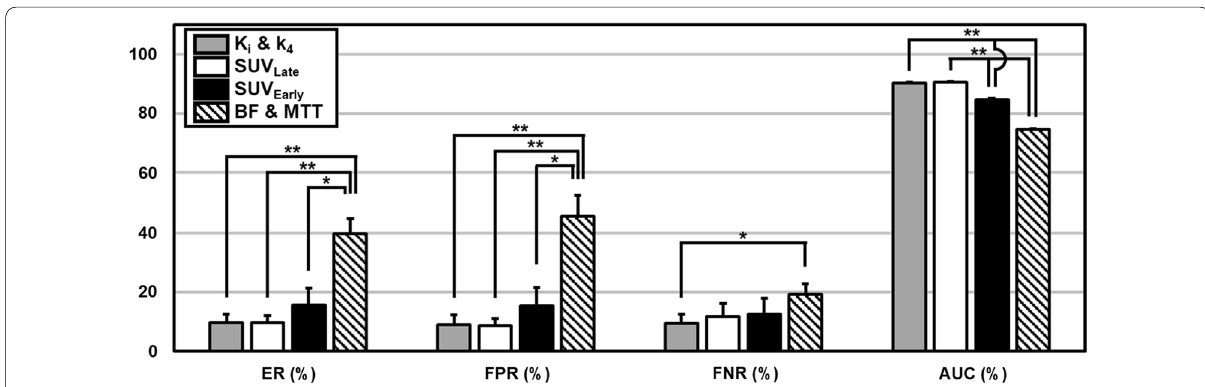
Fig. 3 Comparison of leave‑one‑patient‑out cross‑validation metrics of the different DIL detection models—error rate (ER), false‑positive rate (FPR), false‑negative rate (FNR), and AUC. Error bars are the standard deviation of mean. A significant difference ( P < 0.05) is marked with asterisk (*) for P < 0.05 and double asterisk (**) for P < 0.001. K i Net uptake rate constant, k 4 dissociation rate constant, SUV Late 2‑h post‑injection standardized uptake value,